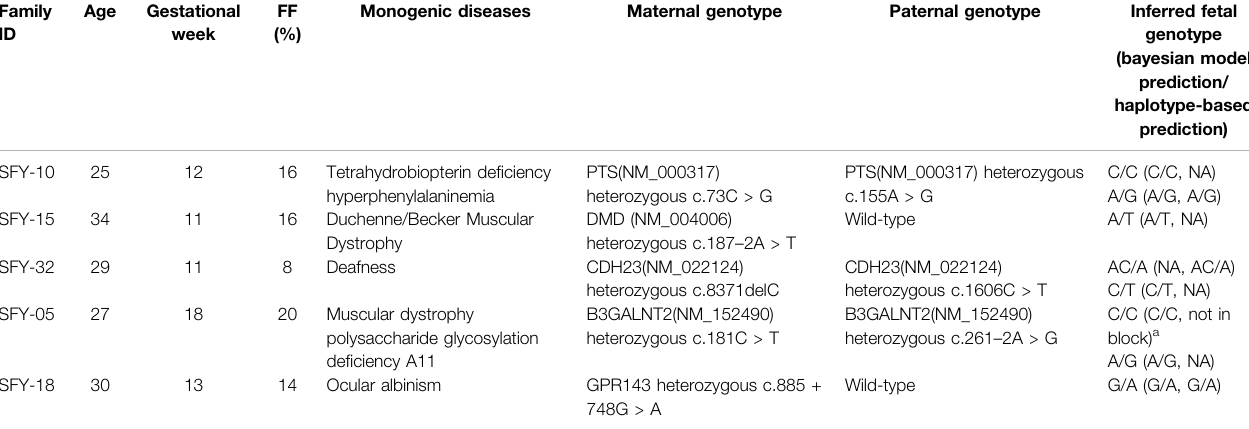
TABLE 2 | Summary of non-invasive prenatal diagnosis in 5 families with monogenic diseases by the combined model. Family